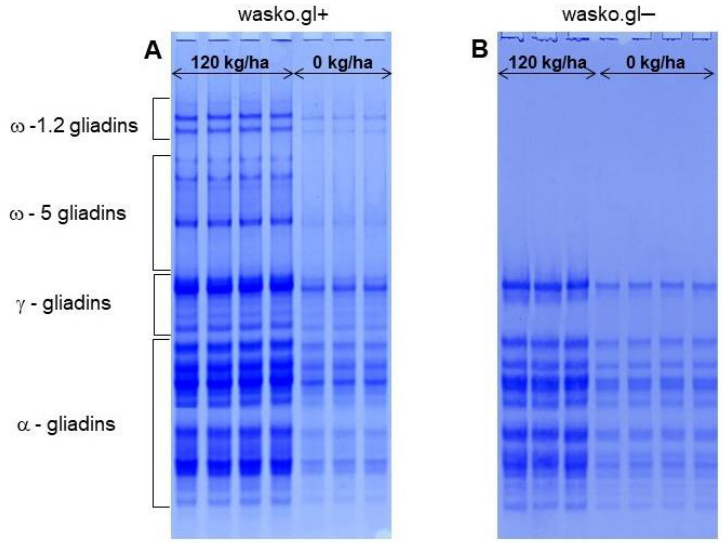
Figure 3. A-PAGE of gliadin proteins extracted from: ( A ): wasko.gl+ wheat control line and ( B ): wasko.gl –, ω -gliadin wheat deficient line, cultivated at the two nitrogen levels: 120 kg N ha −1 (N120, left hand side) and 0 kg N ha −1 (N0, right hand side of the electropherogram).